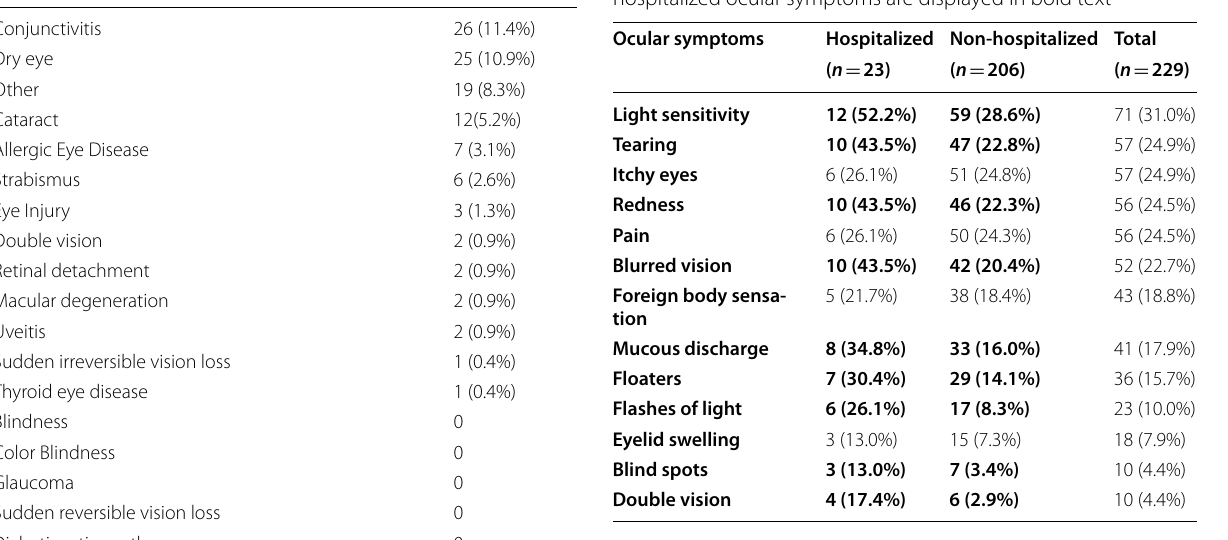
Table 2 Past ocular history reported by survey participants Past Ocular History